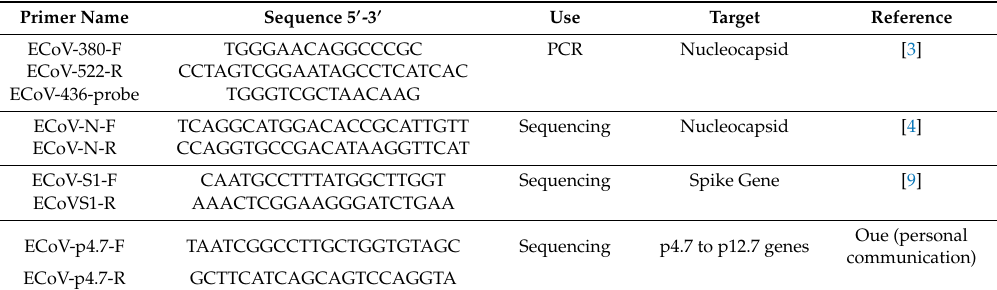
Table 1. Primers and probe for rRT-PCR and sequencing